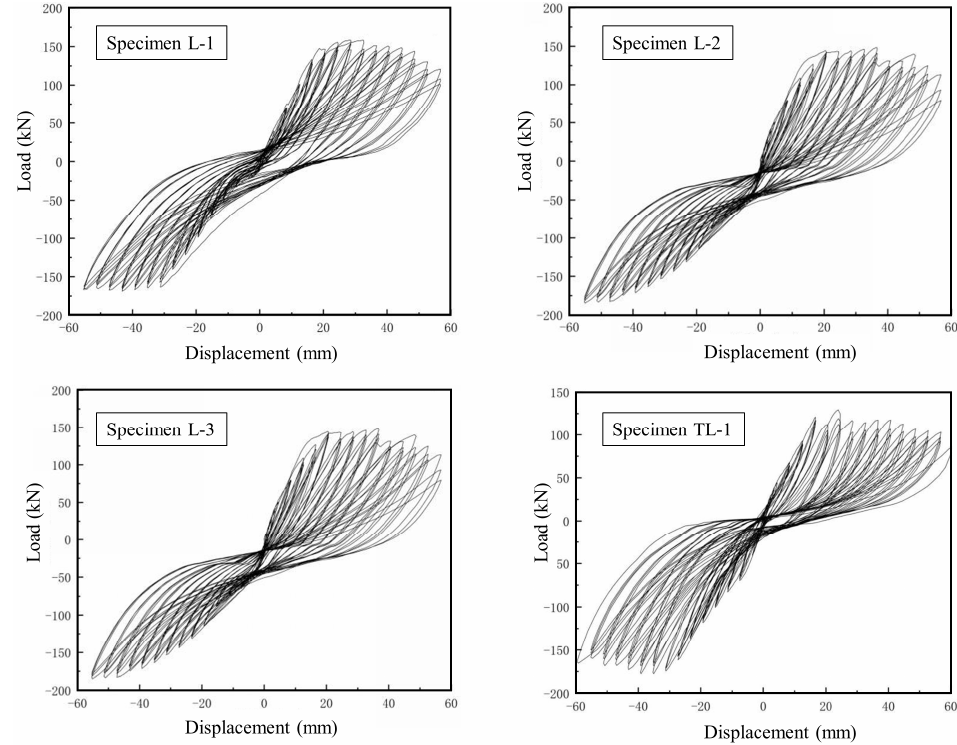
Figure 8. Hysteretic Curve.